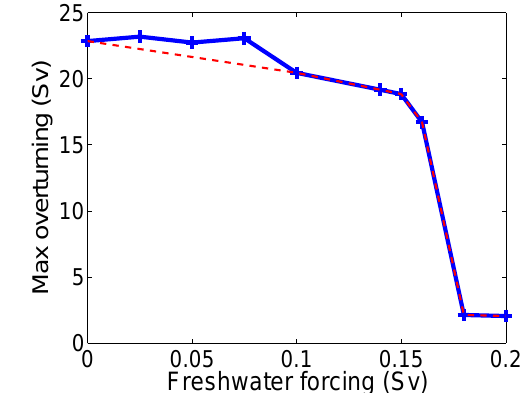
Figure 7. Maximum overturning for freshwater experiments with UVic ESCM 2.9. Freshwater was taken out at 10 to 30 ◦ S and dumped into the Atlantic at 10 to 30 ◦ N prescribing different con- stant amounts of freshwater. For each simulation the maximum overturning is averaged over the last 1000 years of the simulation (blue curve). Each blue cross corresponds to one equilibrium sim- ulation. If the model would not show an AMOC strengthening, the modelled maximum overturning would be expected to follow the red